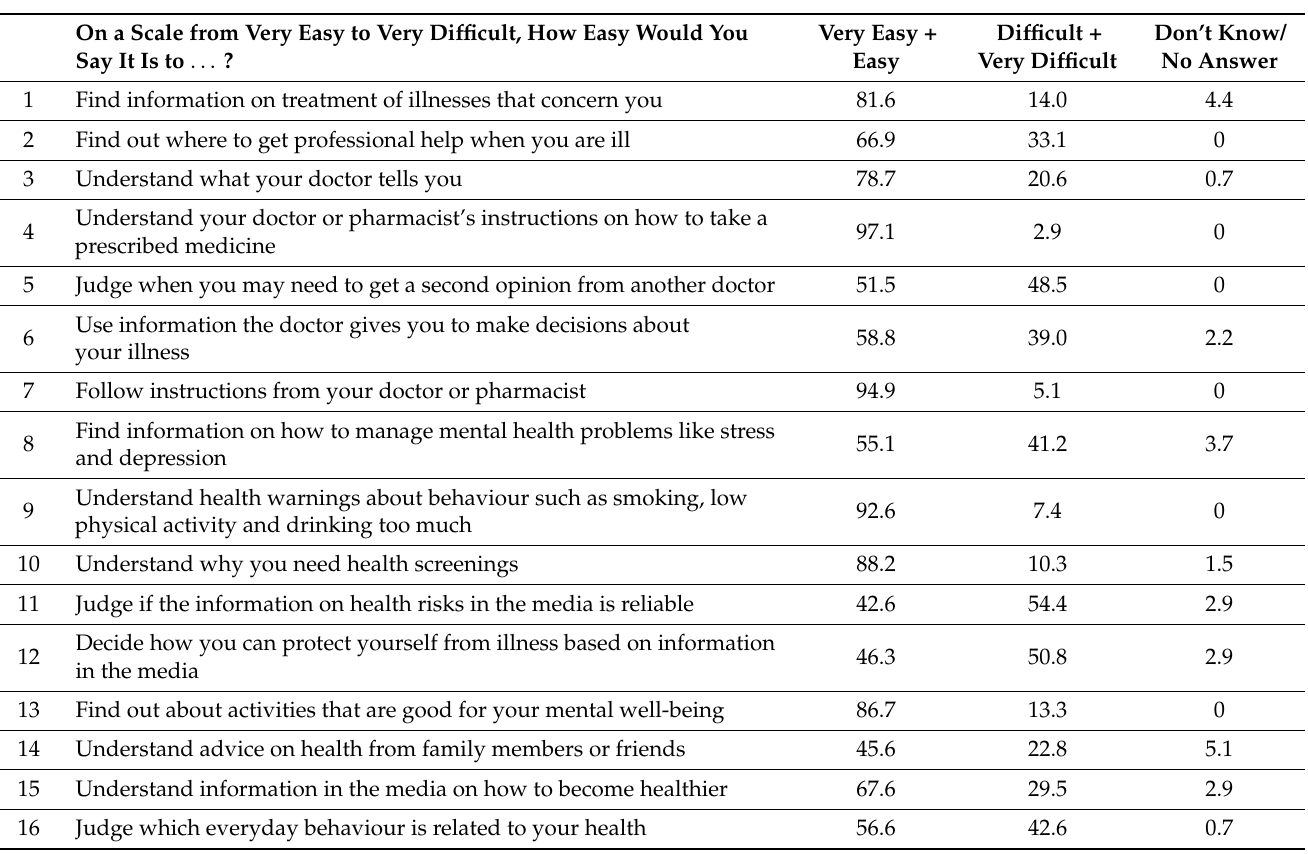
Table 3. Distribution of answers to the items of the HLS-EU-16 scale (%), N =